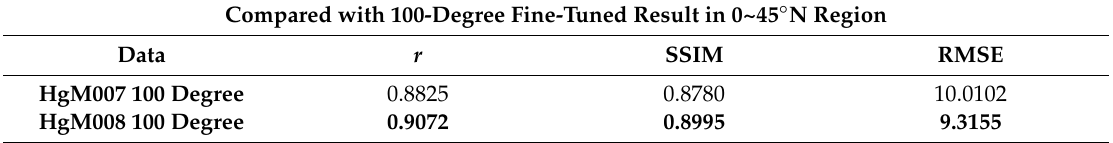
Table 5. Quantitative indicators of stripe-contaminated regions of the HgM007.